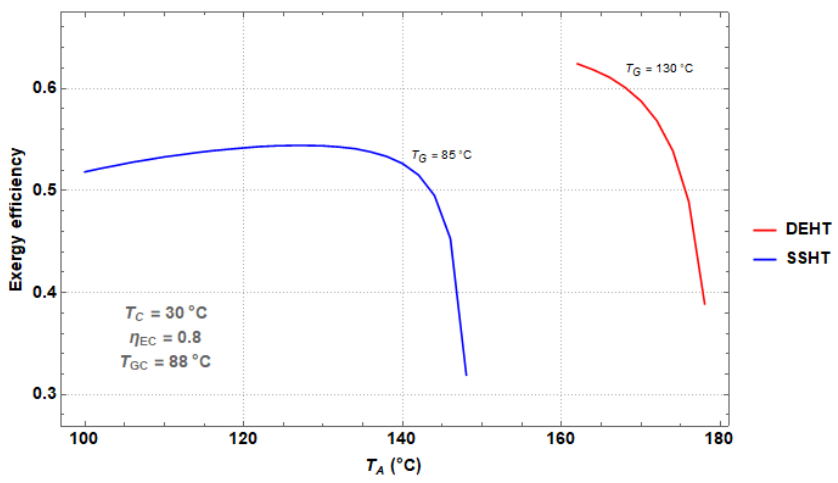
Figure 12. Comparison of the exergy efficiency as a function of T A for the two different heat transformers.